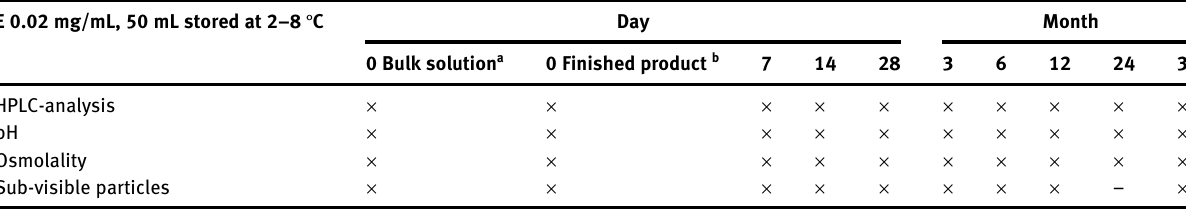
a before autoclaving; b after autoclaving.